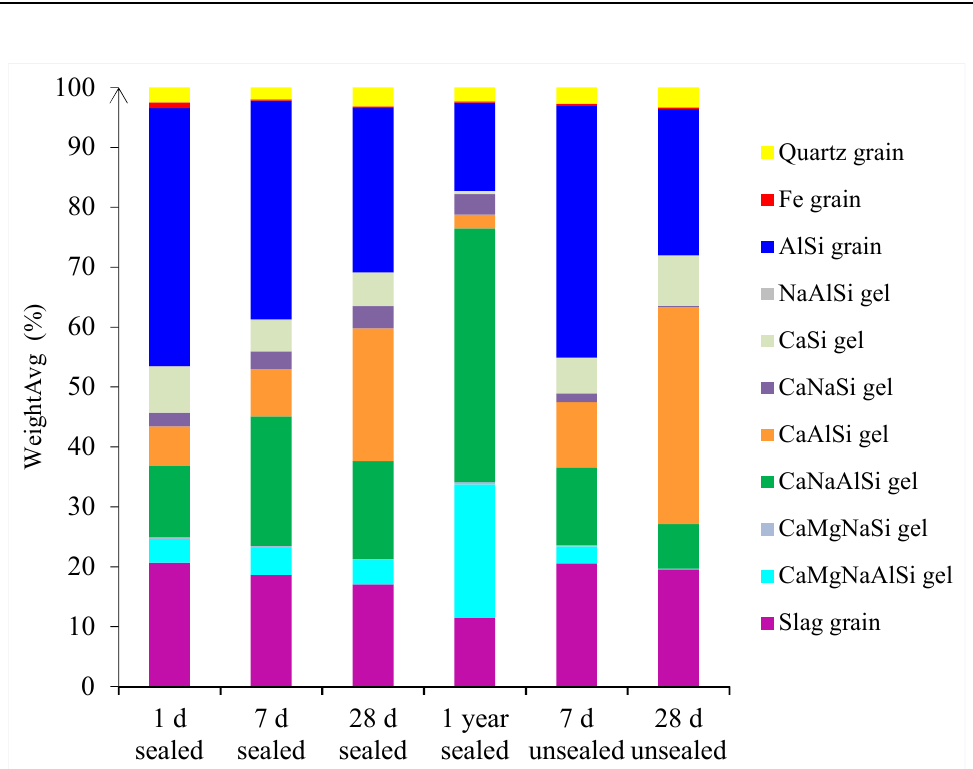
Figure 21. The effect of curing conditions (unsealed and sealed) on the evolution of the phases and their weight proportions in pastes S50. Note that AlSi grain includes all FA phases.